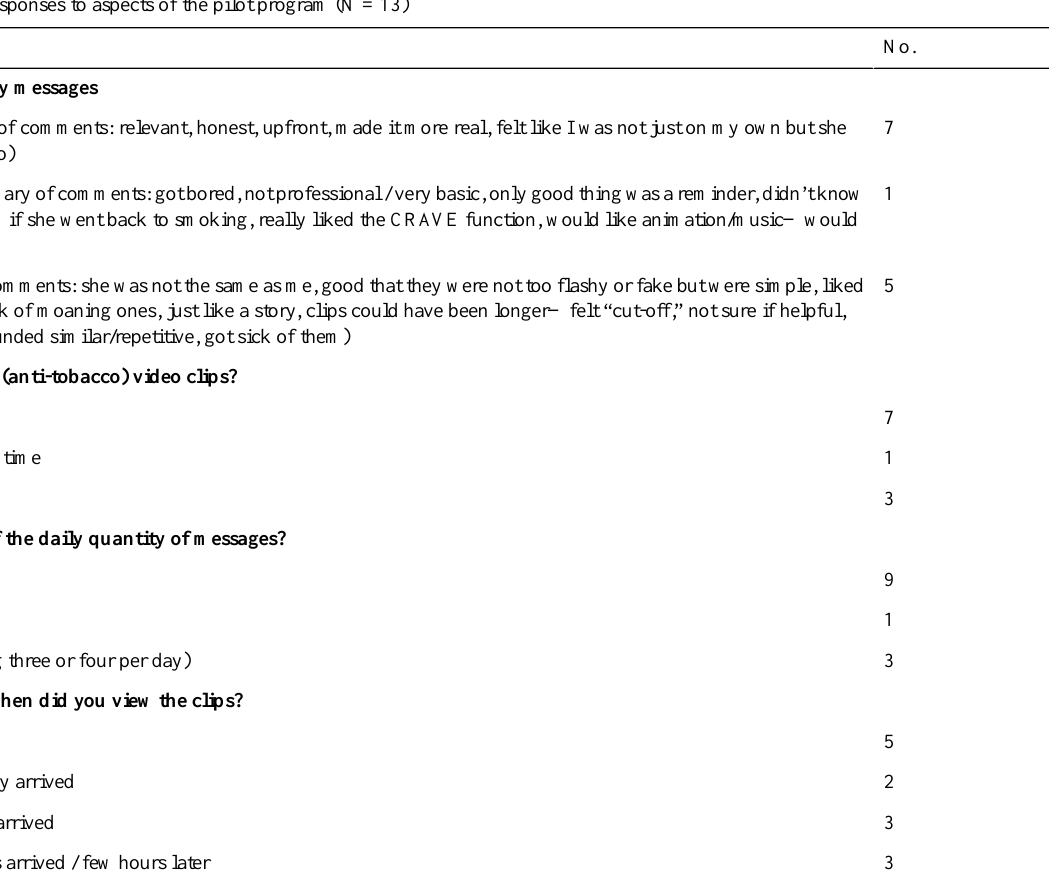
Table 4. Participants’responses to aspects of the pilot program (N = 13) Role model video diary